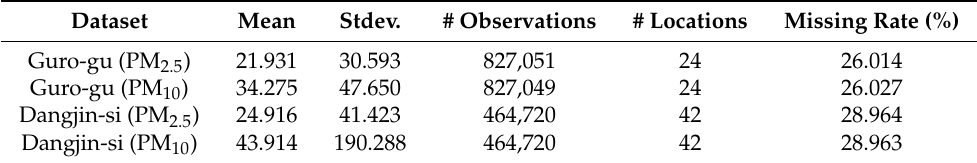
Table 1. Summarization of two air quality datasets. We report the statistics with the whole dataset including training data, validation data and test data. Stdev. denotes the standard deviation of the data. # locations indicates the number of data collection locations. Dataset Mean Stdev. # Observations # Locations Missing Rate